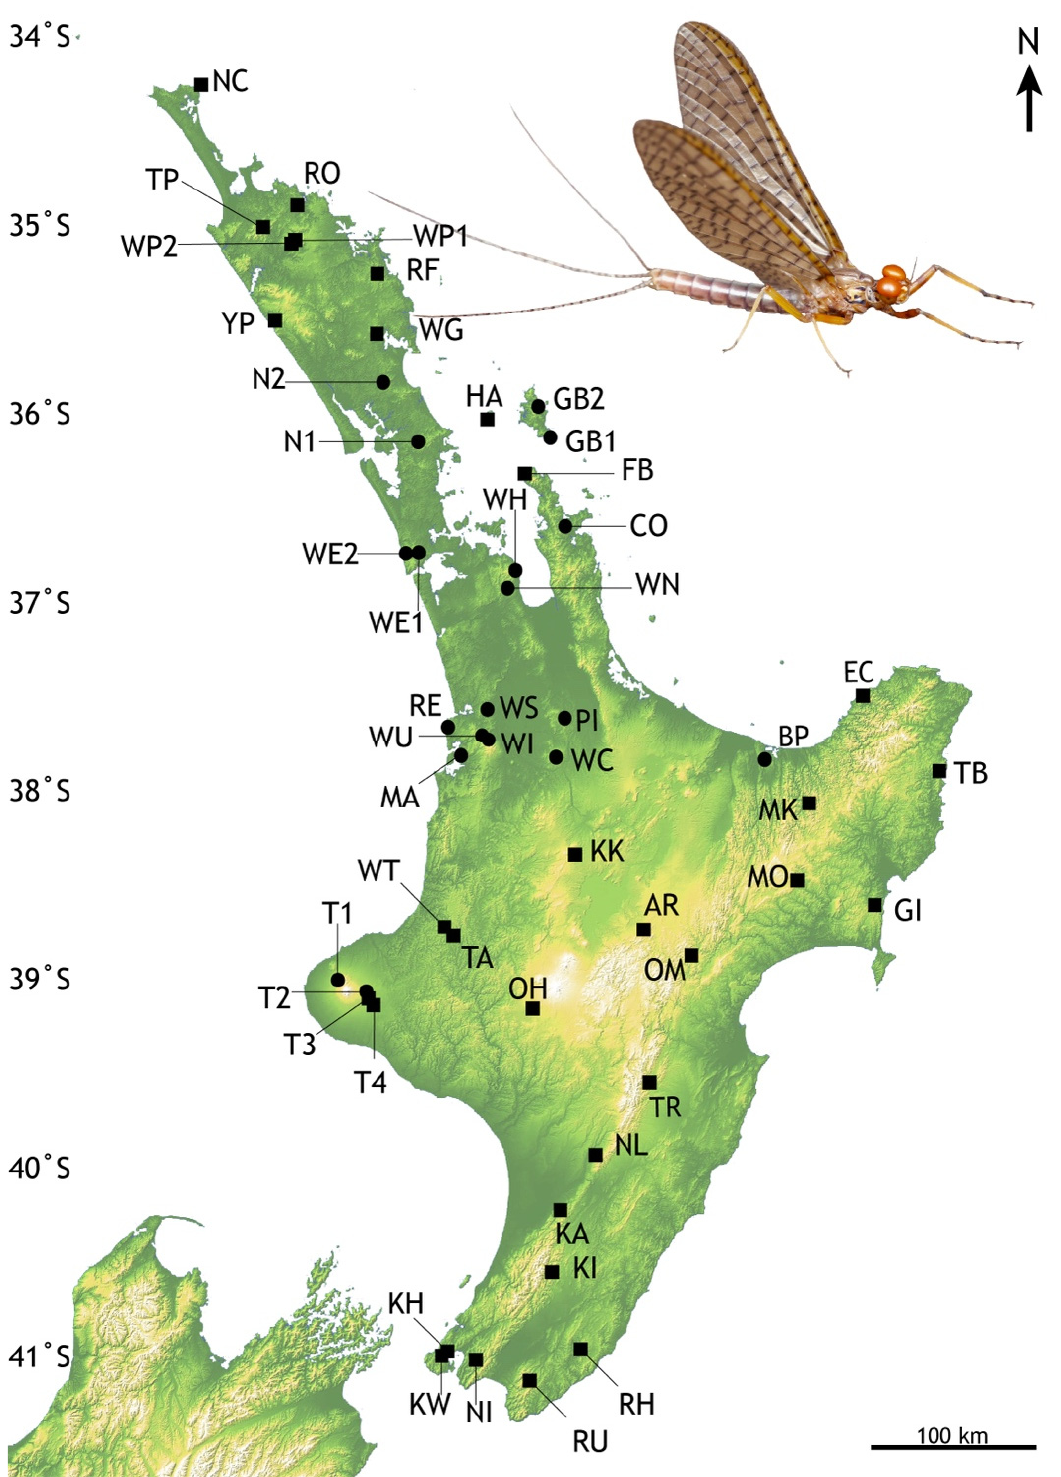
Figure 2. Locations in North Island, New Zealand of Acanthophlebia cruentata population samples. Black circles—previously reported locations [25], black squares ‐ this study. Abbreviated codes refer to locations listed in Table 1. Degrees of latitude are given on the left; north is towards the equator. Inset: Male subimago Acanthophlebia cruentata from Pukenui Forest © Olly Ball and Steve Pohe Col ‐ lection.